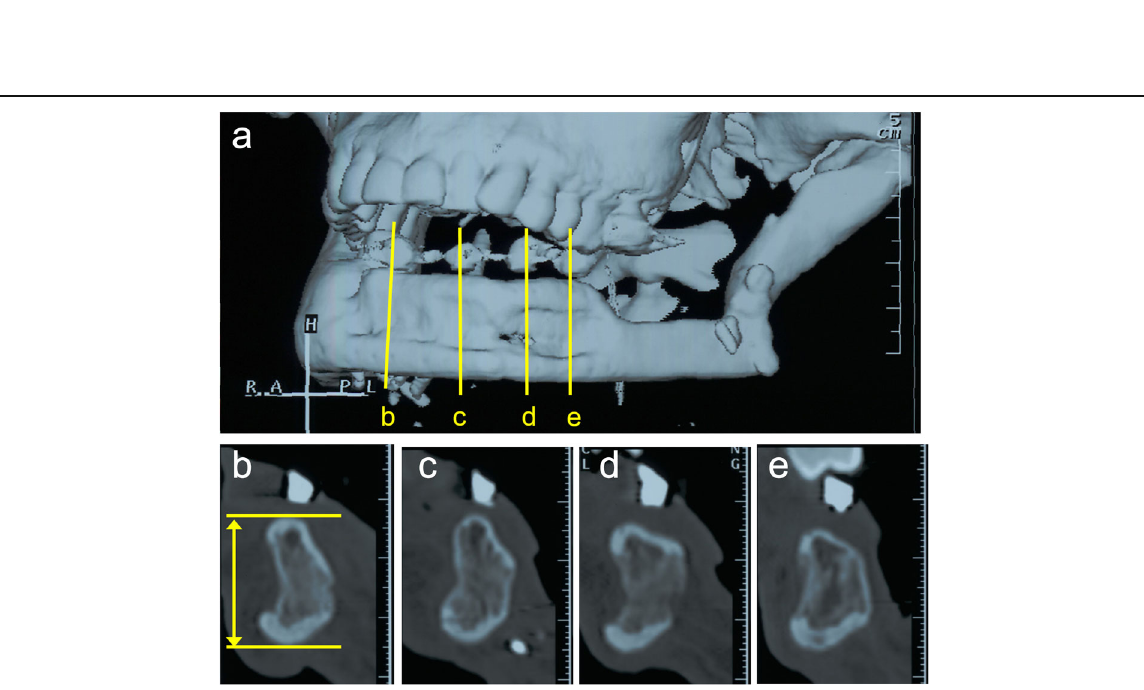
Fig. 5 a 3-D computed tomography scan 7 months after vertical distraction osteogenesis of the free revascularized fibula flap. b – e Cross-sectional images of 7 months after vertical distraction. The height of the distracted fibula was approximately 23 mm